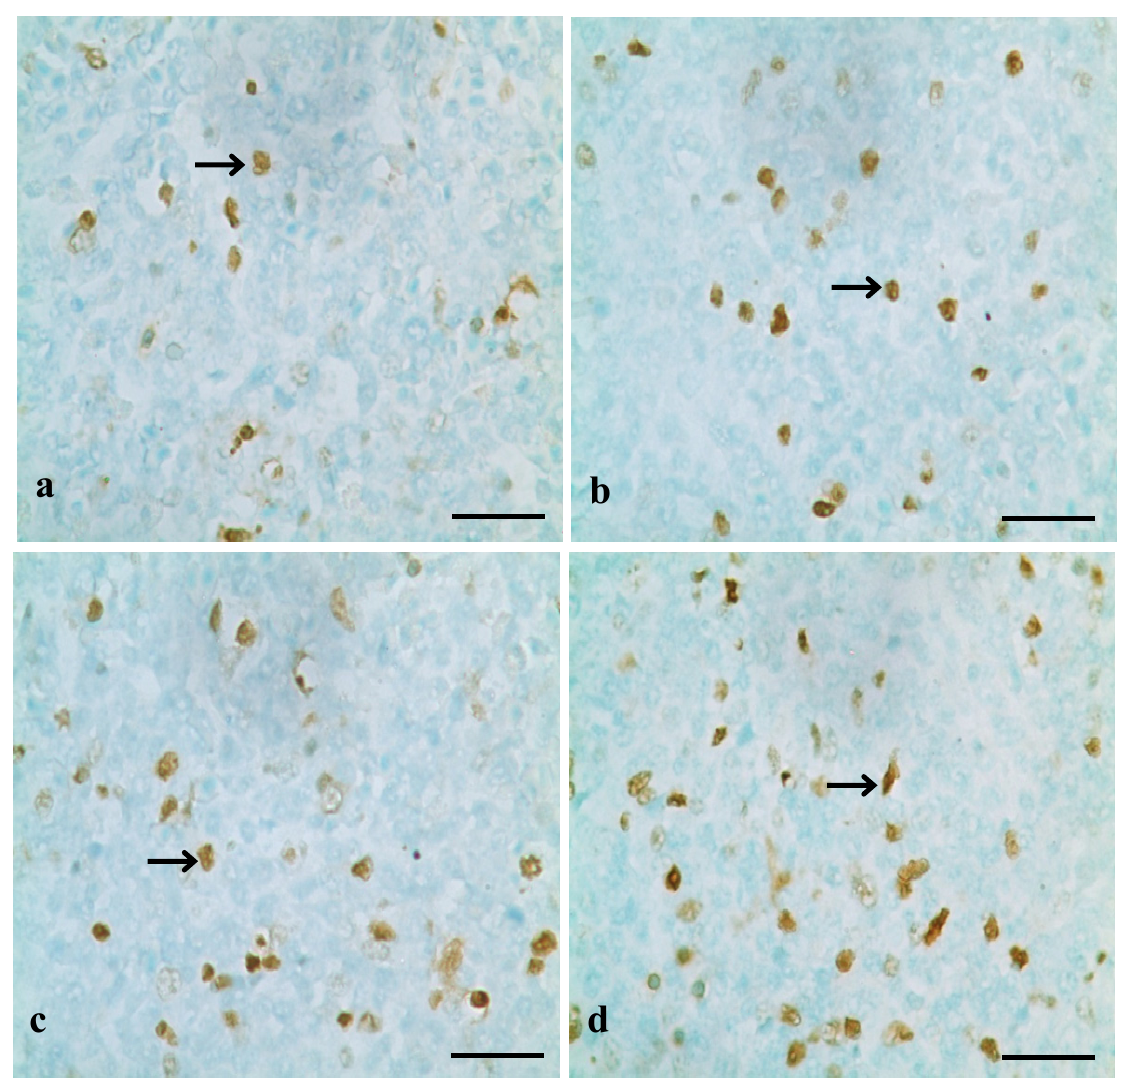
Figure 2. Positive cells stained by TUNEL in the spleen at 28 days of